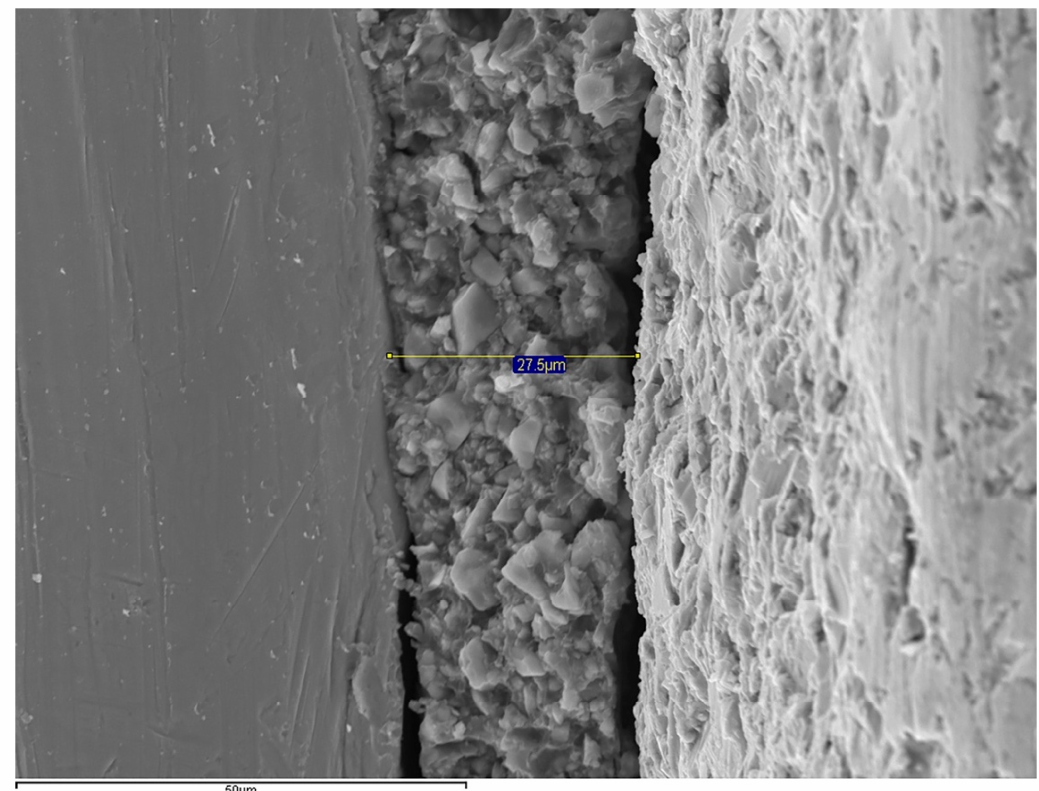
Figure 3. SEM image (1000×) showing the marginal gap in a representative framework of the hard metal milling (HM) group.